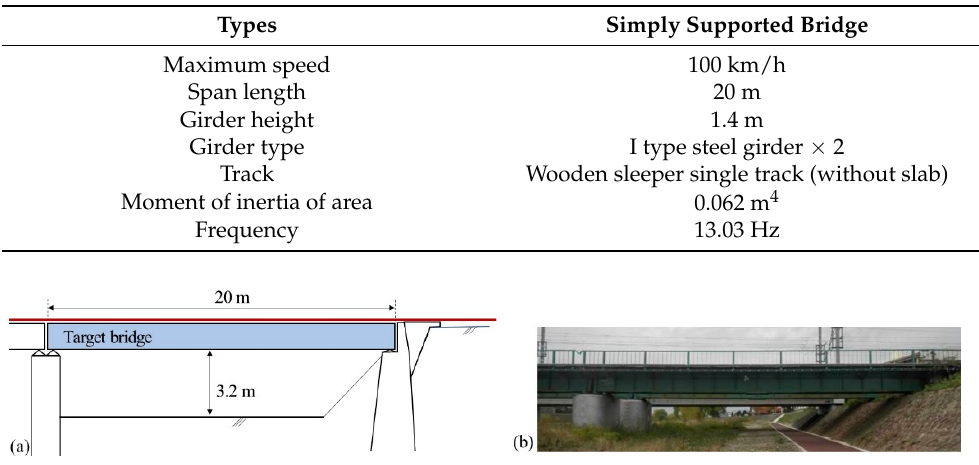
Figure 5. Outline of bridge A: ( a ) bridge span and sketch, ( b ) view of bridge A.